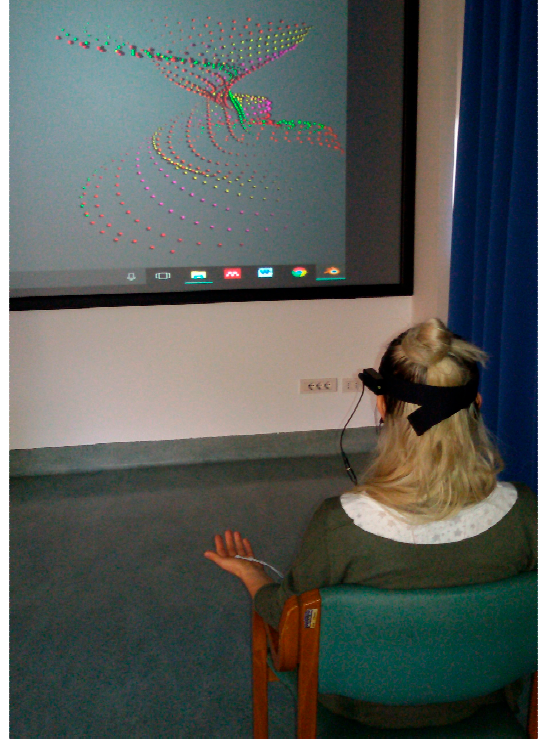
Figure 2. A BCI system controls real-time visualization of DRACLE’s spiral of spheres [32]. Image reproduced with permission of the authors.